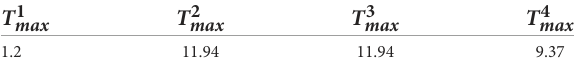
TABLE 1 The comparisons among T 1 max , T 2 max , T 3 max , and T 4 max